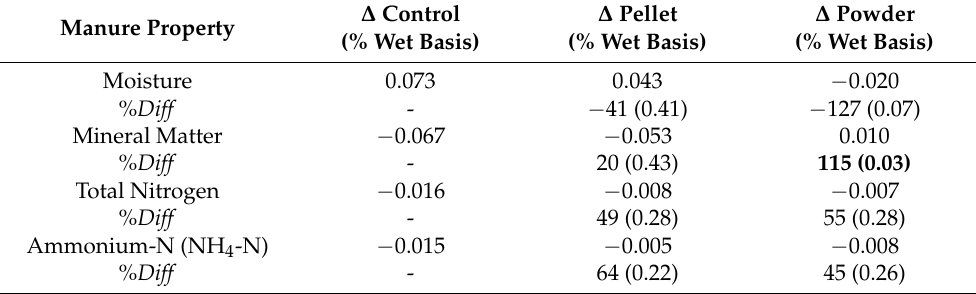
Table 3. The average changes ( ∆ ) in manure properties from ‘before’ and ‘after’ 3-h manure agitation. A negative ∆ value indicates a decrease, and a positive value indicates an increase. Moisture, mineral matter, and targeted chemicals are in units of % wet basis. A negative % Diff indicates manure properties of ∆ Treatment were % Diff less than the manure properties of ∆ Control; a positive % Diff indicates otherwise. The bold font indicates statistical significance. The p -values are listed inside